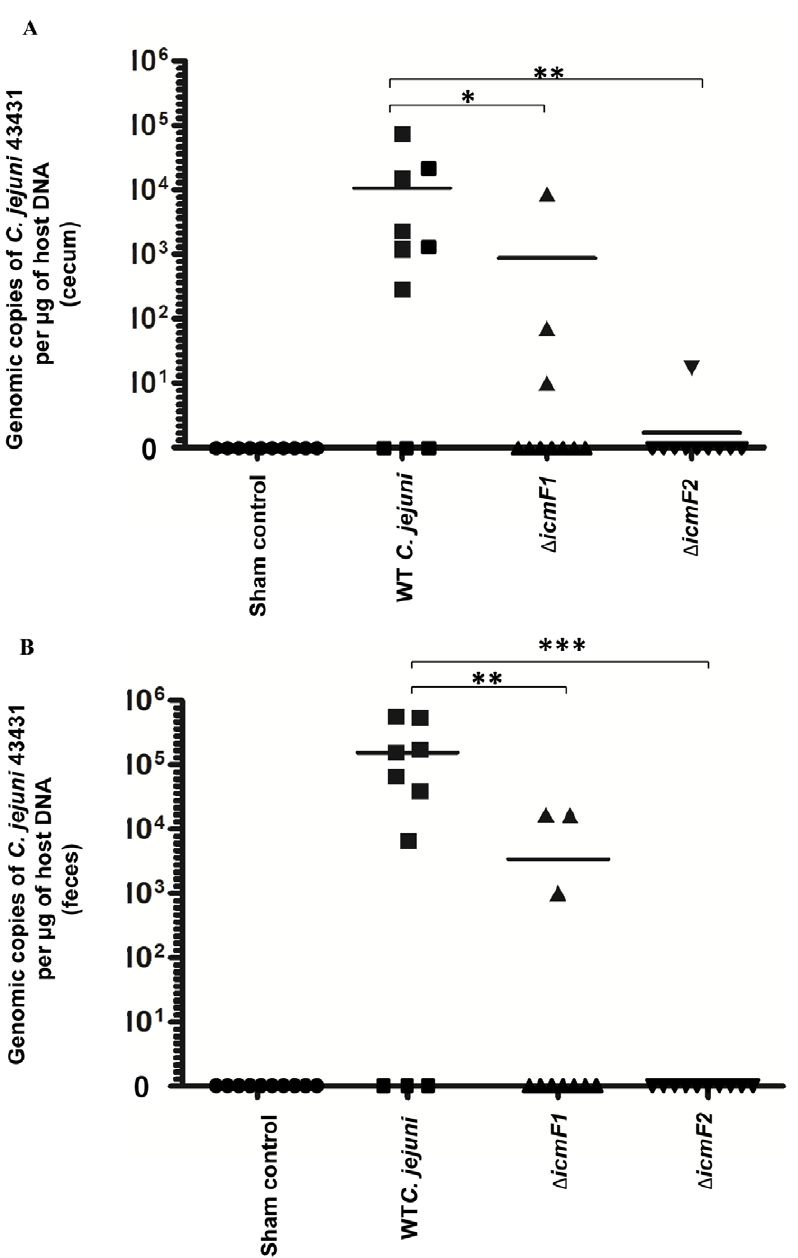
Figure 8. Colonization potential of WT C.jejuni , the D icmF1 mutant, and the D icmF2 mutant in IL-10-deficient mice at 30 days post- infection. The number of WT C. jejuni 43431 and the mutants in the cecum (A) and the feces (B) of individual mice were quantified by Q-PCR (see Material and Methods ) and the values plotted. A solid line represents the mean value for each group. P value: * # 0.05, ** # 0.01, *** # 0.001.